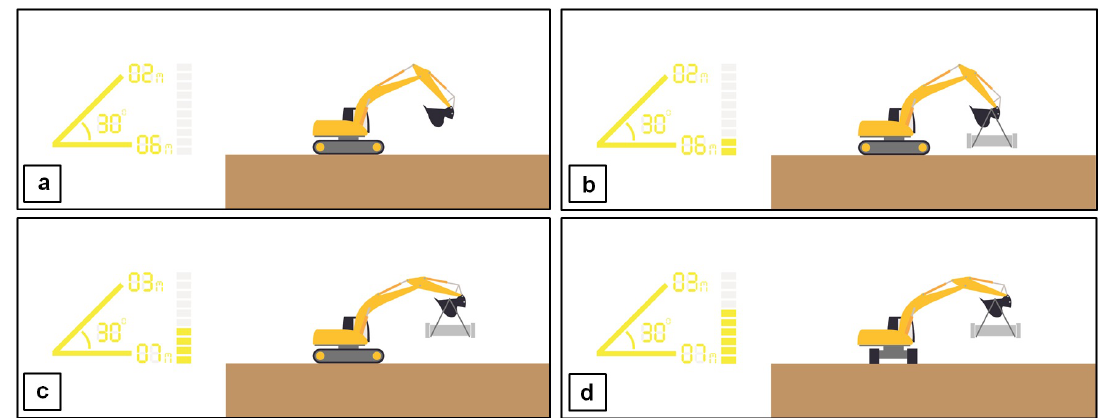
Figure 10. ( a ) Since the bucket is empty and there is no object being lifted, the relative load capacity is zero. ( b ) The excavator is lifting a pipe, where the height is 2 m and the distance is 6 m. In this position, the relative load capacity is 20%. ( c ) Still lifting the same pipe, but both height and distance are increasing, thus the relative load capacity goes higher. ( d ) Still lifting in the same position, but now the lifting direction is across the undercarriage, and thus the relative load capacity goes even higher.